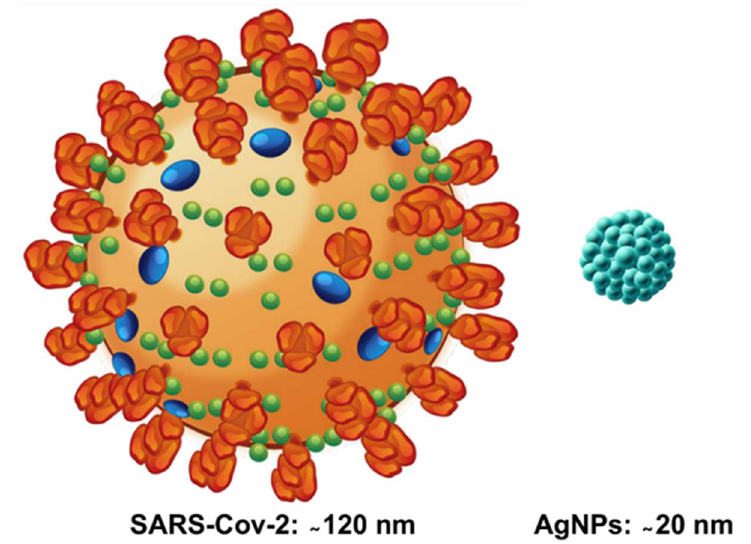
Figure 1. Size comparison between the average sizes of the SARS-Cov-2 coronavirus and a single silver nanoparticle (AgNPs). Both structures are at a proportional size.